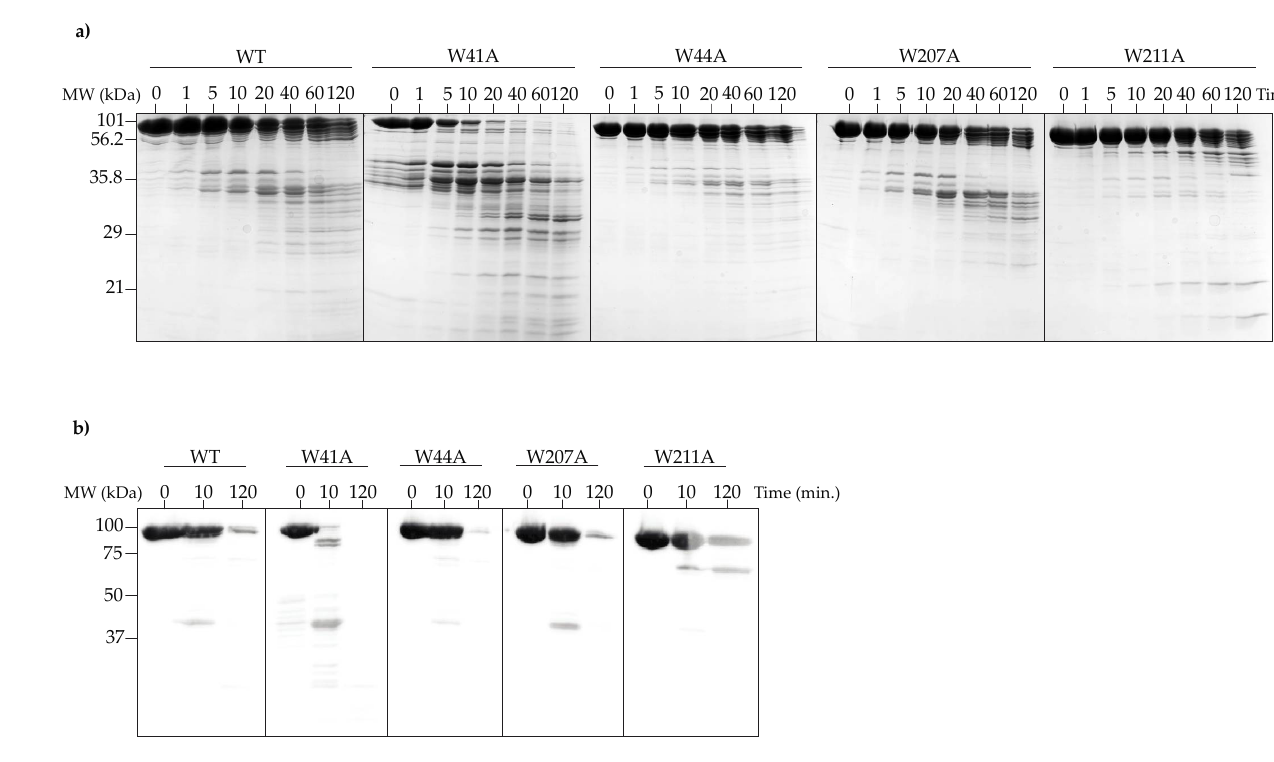
Figure 6. Tertiary structure of WT and mutant PC portal rings probed by proteolytic digestion with α-chymotrypsin at 37 °C. ( a ) 12.5% SDS-PAGE showing proteolytic digestion of PC portal rings. The 0 min lane shows the full-length portal proteins without protease added; ( b ) fluorescent Western blot using anti-6x-His Tag antibody showing proteolytic digestion of PC portal rings. The his-tag is on the C-terminus of the portal proteins.